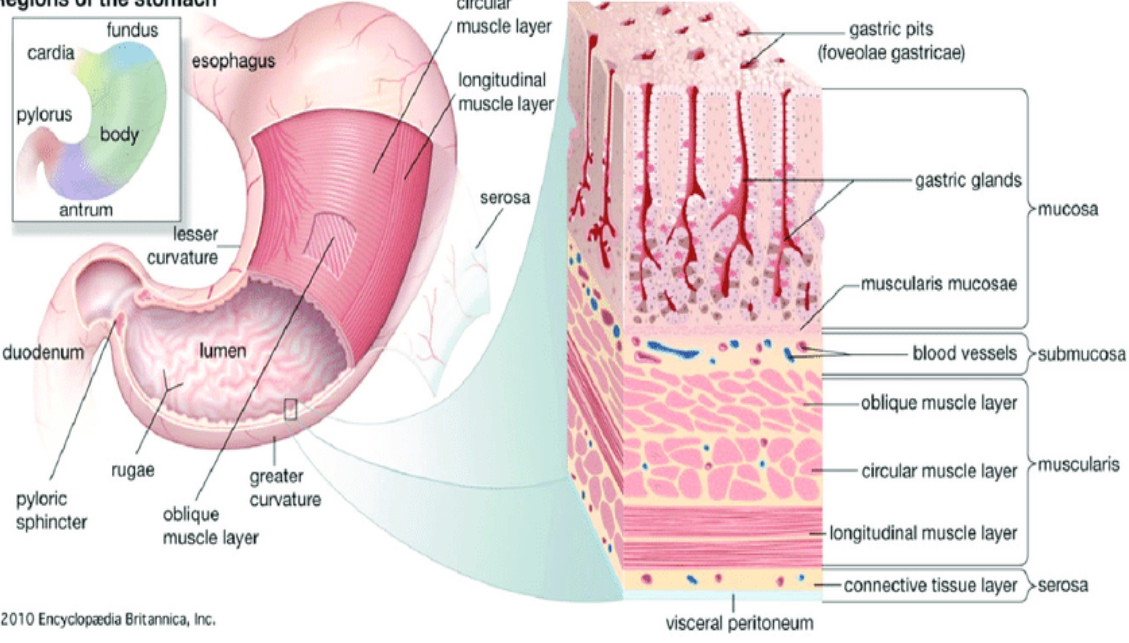
Figure 1. Structure of the human stomach and gastric wall